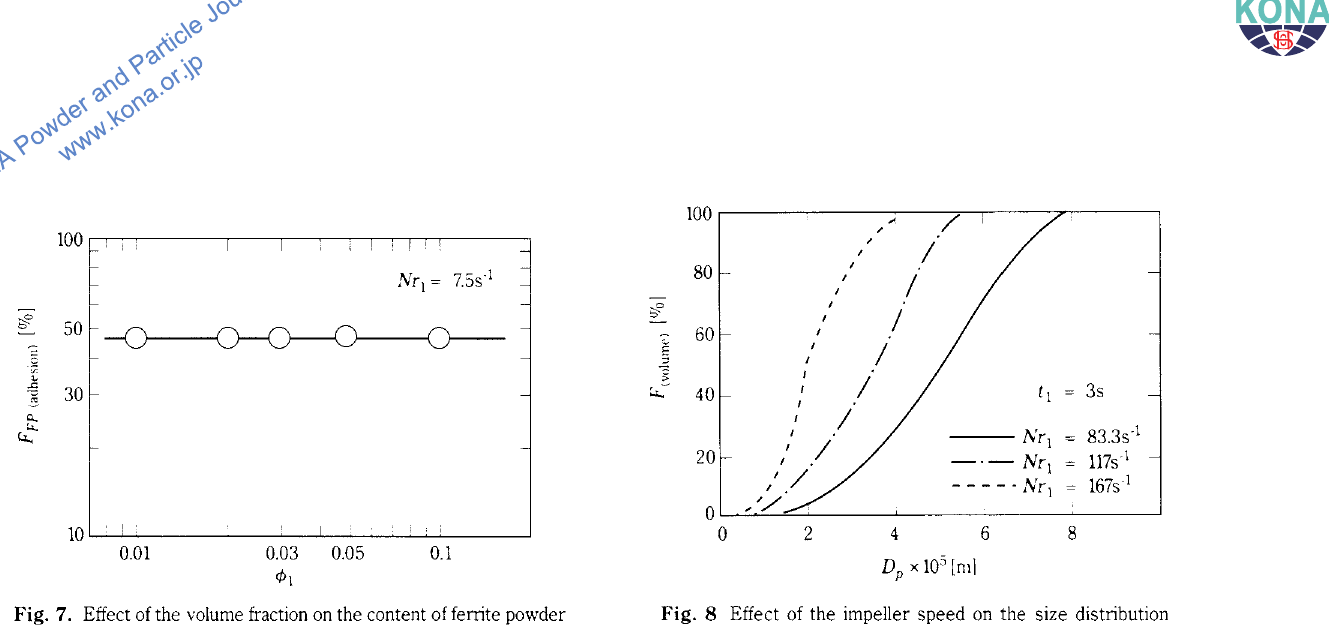
Fig. 7. Effect of the volume fraction on the content of ferrite powder Wherein, D1 and We are impeller diameter and mixing Weber number, respectively. Values of con